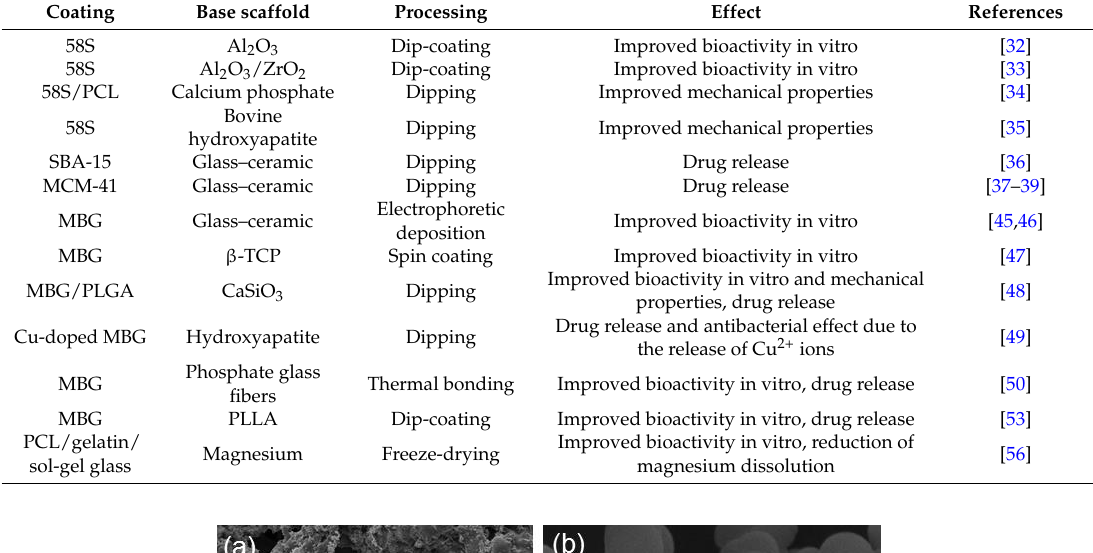
Table 2. Scaffolds provided with a mesoporous coating.